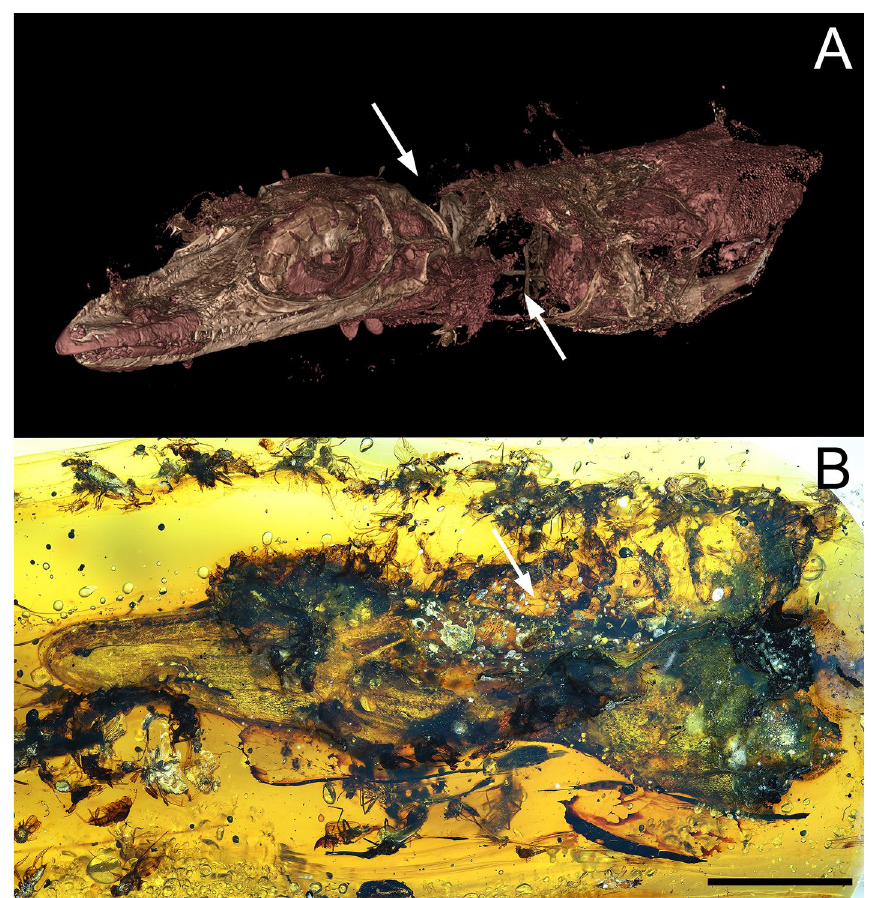
Figure 1. Piece GRS-Ref-28627 with Oculudentavis naga Bolet et al. 39 . ( A ) Virtual representation of Oculudentavis in frontolateral view (arrows show the place where the soft tissues were already partially consumed). ( B ) Photograph of Oculudentavis in ventrolateral view (arrow shows the place where most of the flies were trapped into the resin), as observed in side A. Scale bar 1 mm. Arnau Bolet provided high resolution photo for